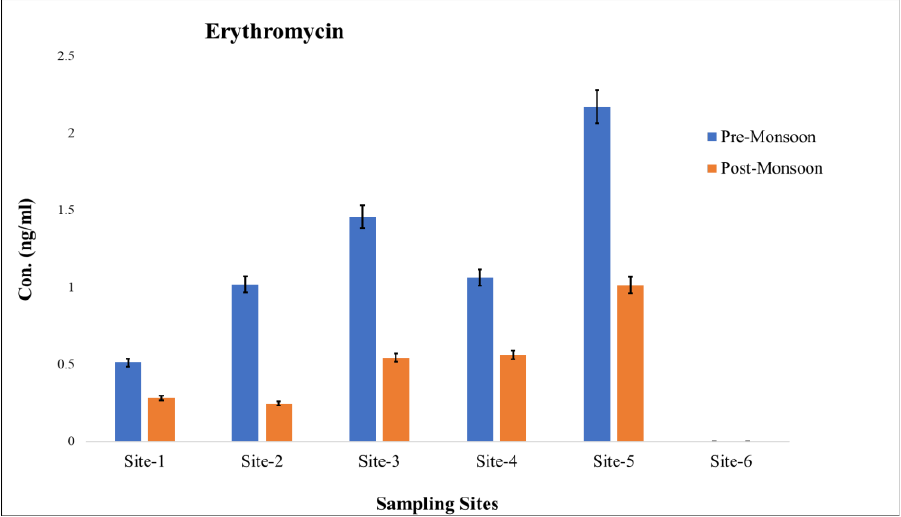
Figure 4. Erythromycin concentration in surface water samples from various areas along the Ya- muna River in Delhi, India. River in Delhi,